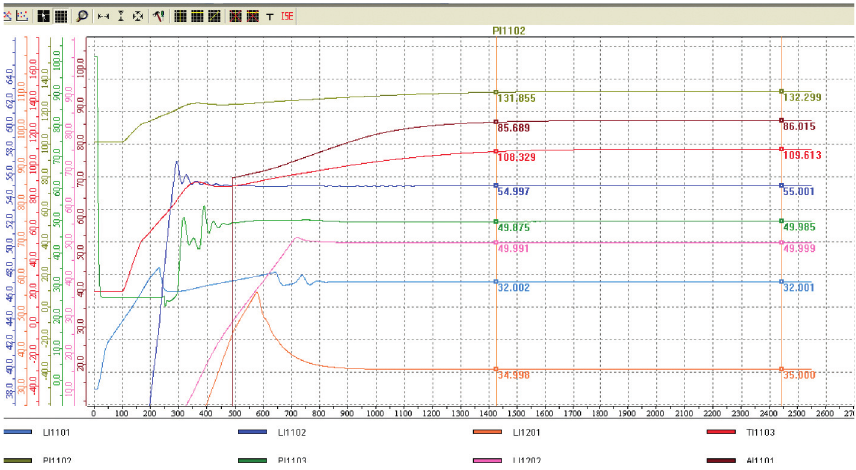
Figure 16: Improved automatic disturbance rejection control b �